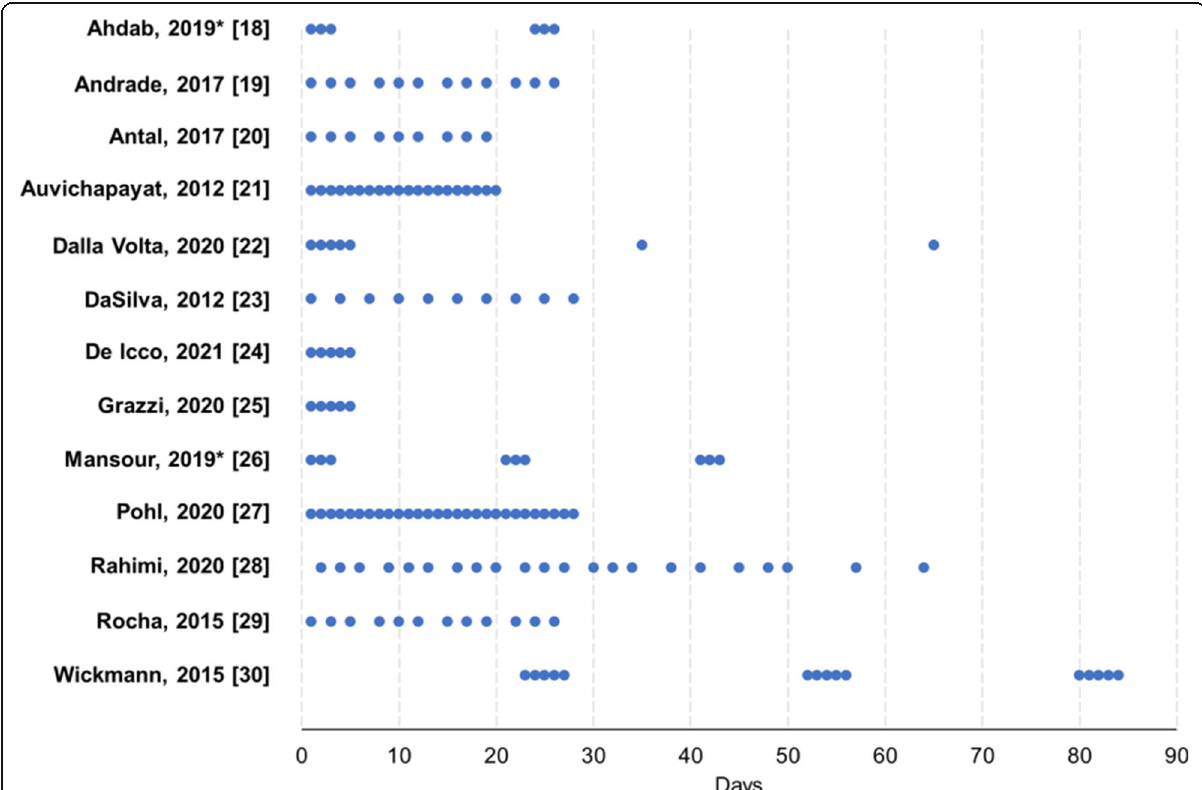
Fig. 2 Overview of transcranial direct current stimulation schedules in the included randomized controlled trials. Each dot represents a single session. *cross-over trial; each group of dots represents a different